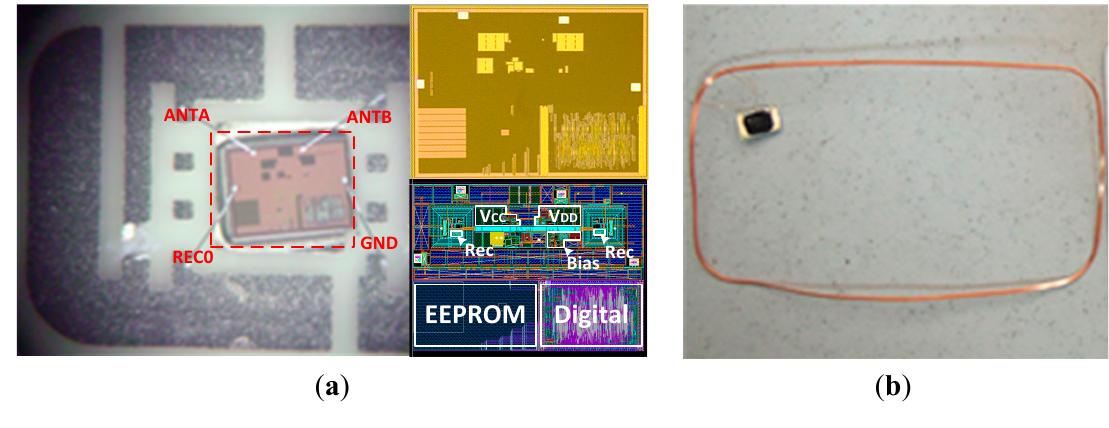
Figure 14. ( a ) Photograph of packaged RFID tag. Chip microphotograph and layout. ( b ) Chip tag used in a RFID smart